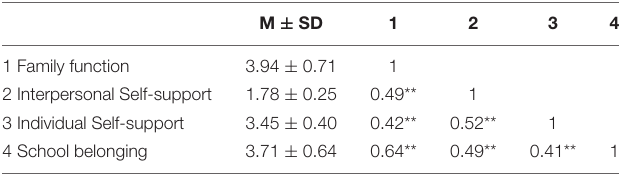
TABLE 1 | Descriptive statistics and correlation analysis for the main